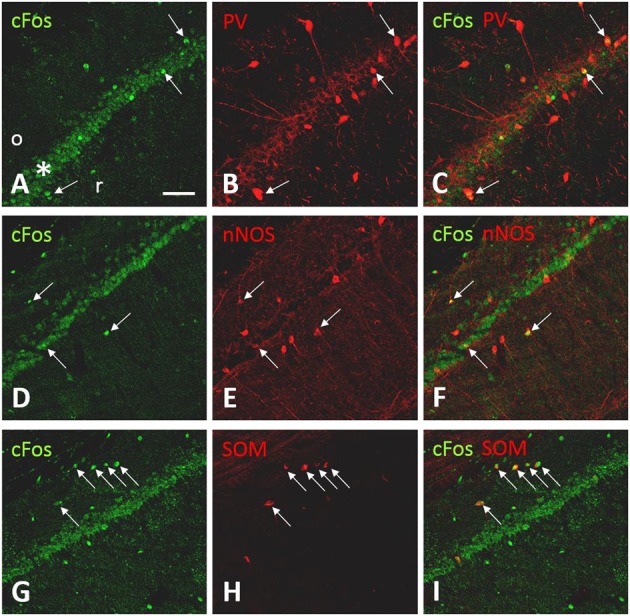
c-Fos-ir in CA1 is co-localized with markers of interneurons in CA1. Confocal fluorescent images showing the colocalization of c-Fos-ir and the interneuron markers parvalbumin (PV), neuronal nitric oxide synthase (nNOS), and somatostatin (SOM) in the field CA1 of the ipsilateral hippocampus following carbachol microinjection into the lSuM. c-Fos-ir was detected in the stratum pyramidale (∗), stratum oriens (o), and radiatum (r; A,D,G). (B,E,H) illustrate the expression of PV-ir, nNOS-ir, and SOM-ir. Double-labeled neurons (arrows) were identified in stratum oriens, pyramidale, or radiatum (C,F,I). Scale bar represents 100 μm.